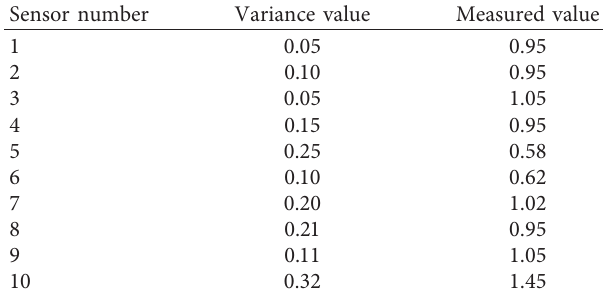
Table 1: Measurement results and sensor variance